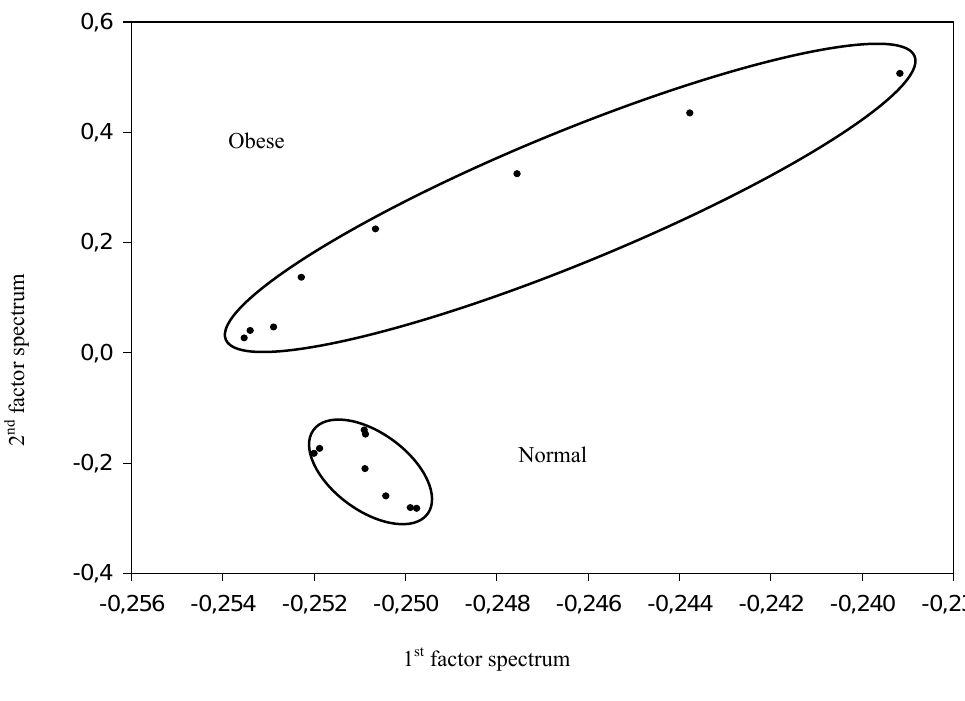
Figure 4. PCA map showing two distinct zones where appears the control spectra on one hand, and the obese spectra on the other